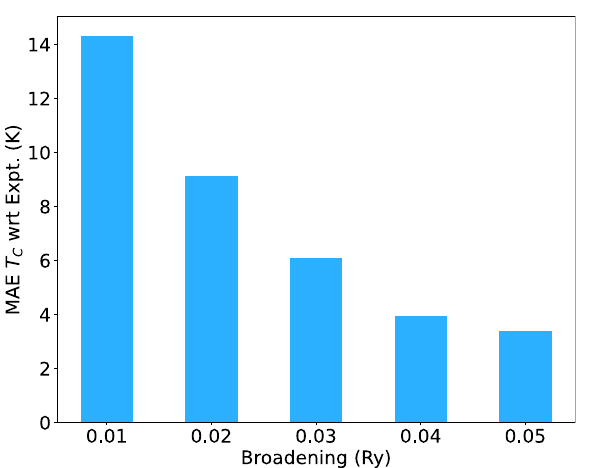
Fig. 3 Broadening convergence with respect to experimental T C data for 14 superconductors. Table 1. Comparison of JARVIS-Tools screening work fl ow based